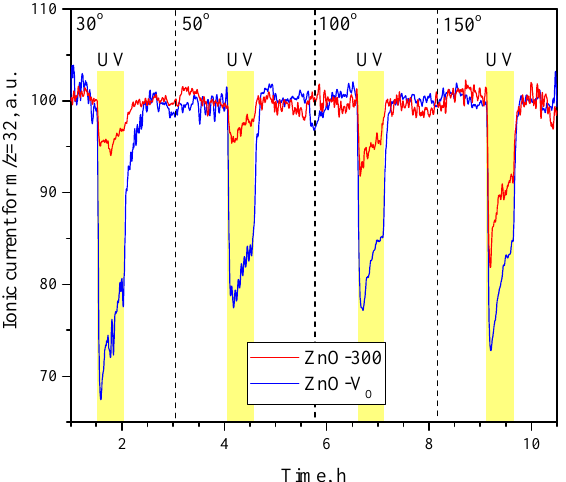
Figure 9. Comparative baseline-corrected graphics showing photoadsorption of oxygen from carrier gas on ZnO-300 (1) and ZnO-V O (2) tablets under UV light illumination (370 nm) in the temperature range of 30–150 ◦ C, determined from the ion current by m / z =